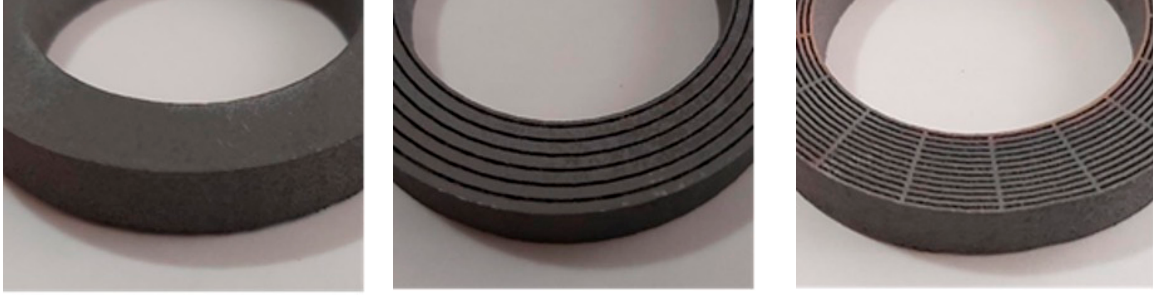
Figure 4. Internal section of sample-ring manufactured for magnetic characterization of FeSi3 and FeSi6.5. The magnetic properties, measured for the six samples described above, were obtained by means of the experimental set-up shown in Figure 5.